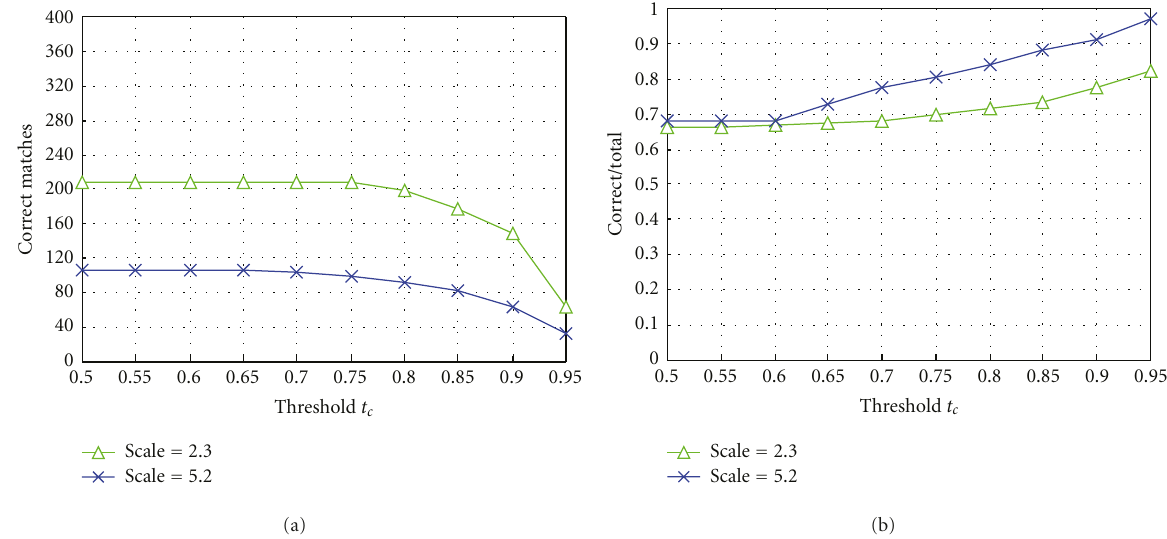
Figure 7: Evaluation for di ff erent threshold t c . (a) This graph shows the number of correct matches with respect to the threshold t c under di ff erent scale changes. (b) This graph shows the ratio of correct matches to total matches with respect to the threshold t c under di ff erent scale changes. The results are obtained from images in “Boat” sequence (frames 0 and 5) and images in “East south” sequence (frames 0, and 9). The scale change between images in “Boat” sequence is 2.3, and the rotation angle is about 9 degrees. The scale change between images in “East south” sequence is 5.2, and the rotation angle is about 59